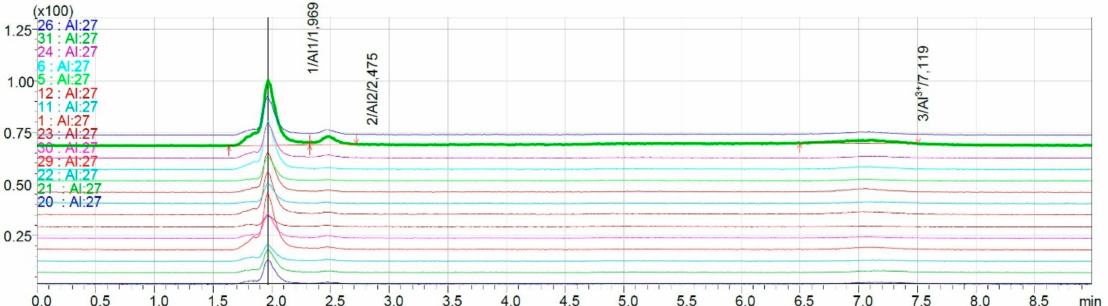
Figure 6. Overlapped chromatograms obtained for analyzed red wine samples.